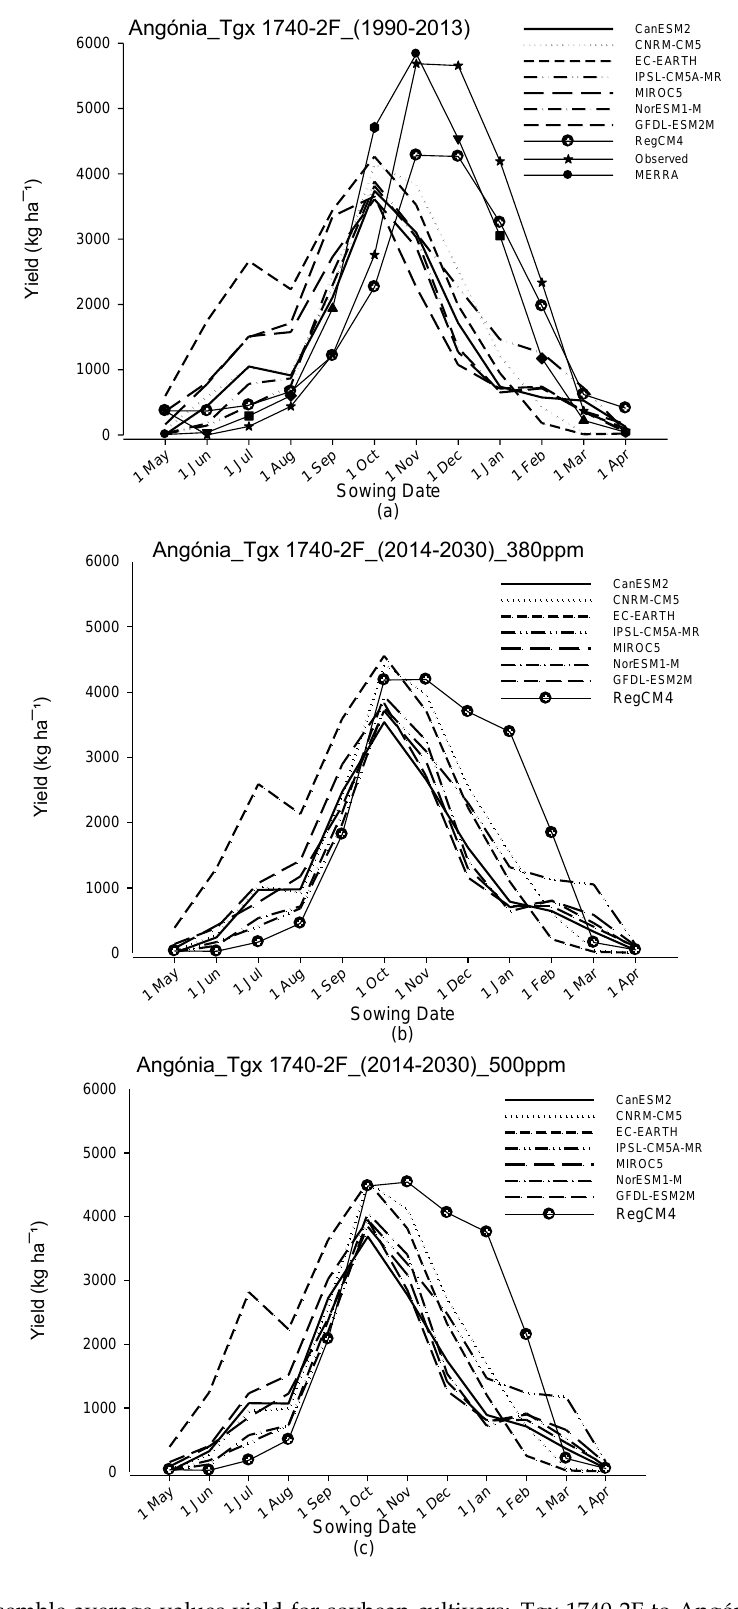
Figure 4. Ensemble average values yield for soybean cultivars: Tgx 1740-2F to Angónia, (climatic estimated data RegCM4, CanESM2, CNRM-CM5, EC-EARTH, IPSL-CM5A-MR, MIROC5, NorESM1-M and GFDL-ESM2M): ( a ) in the period from 1990 to 2013, ( b ) in the period from 2014–2030 (380 ppm CO 2 ), ( c ) in the period from 2014–2030 (500 ppm CO 2 ).